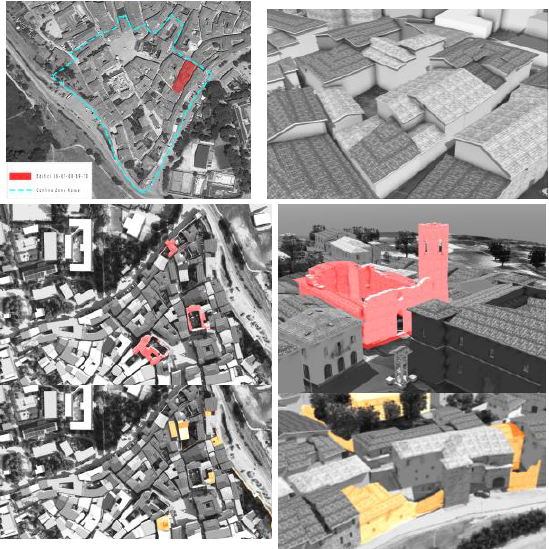
Figure 12. Classification of damage degree to the multiscale models of Norcia. (developed in LOD 2, 3 or 4)